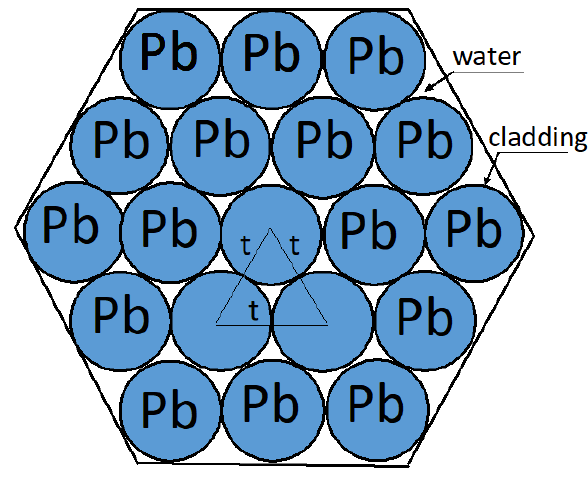
Figure 7. FA with heavy neutron moderator (lead).